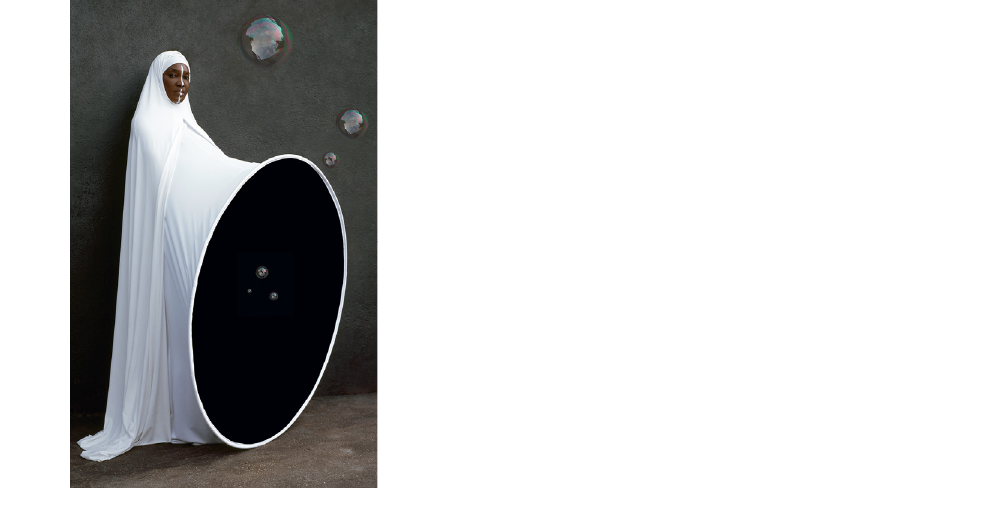
Figure 4. Maïmouna Guerresi, Genitilla–al-Wilada, 2007. Lambda print on aluminum. 200 × 125 cm. © Maïmouna Guerresi, courtesy Mariane Ibrahim Gallery.